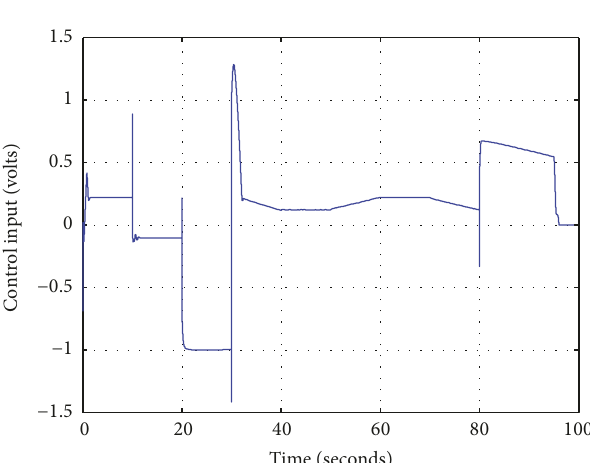
Figure 18: Control input to heating process.